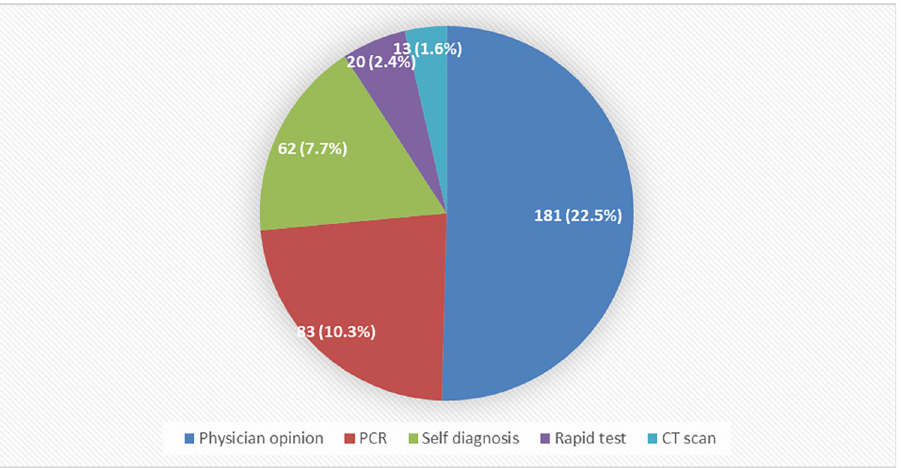
Fig 1. Methods used to diagnose COVID-19 in 301 participants who reported at least one COVID-19 infection. PCR: Polymerase Chain Reaction; CT scan: Computed tomography scan.